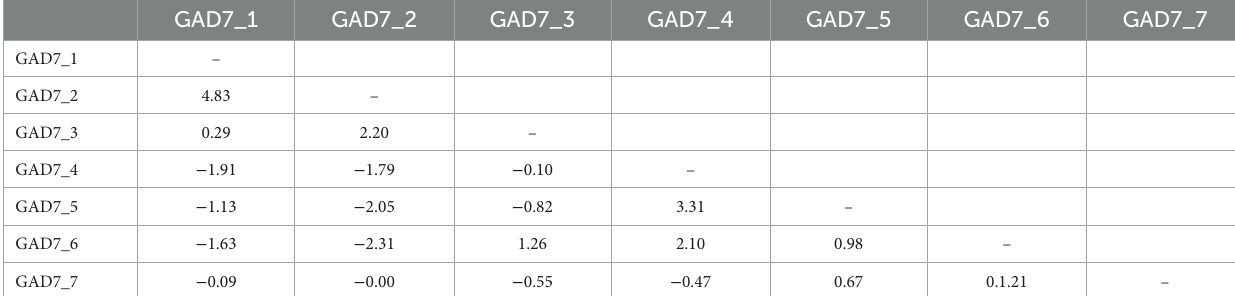
TABLE 5 Jacknife Slope Index (JSI) for pair ítems of